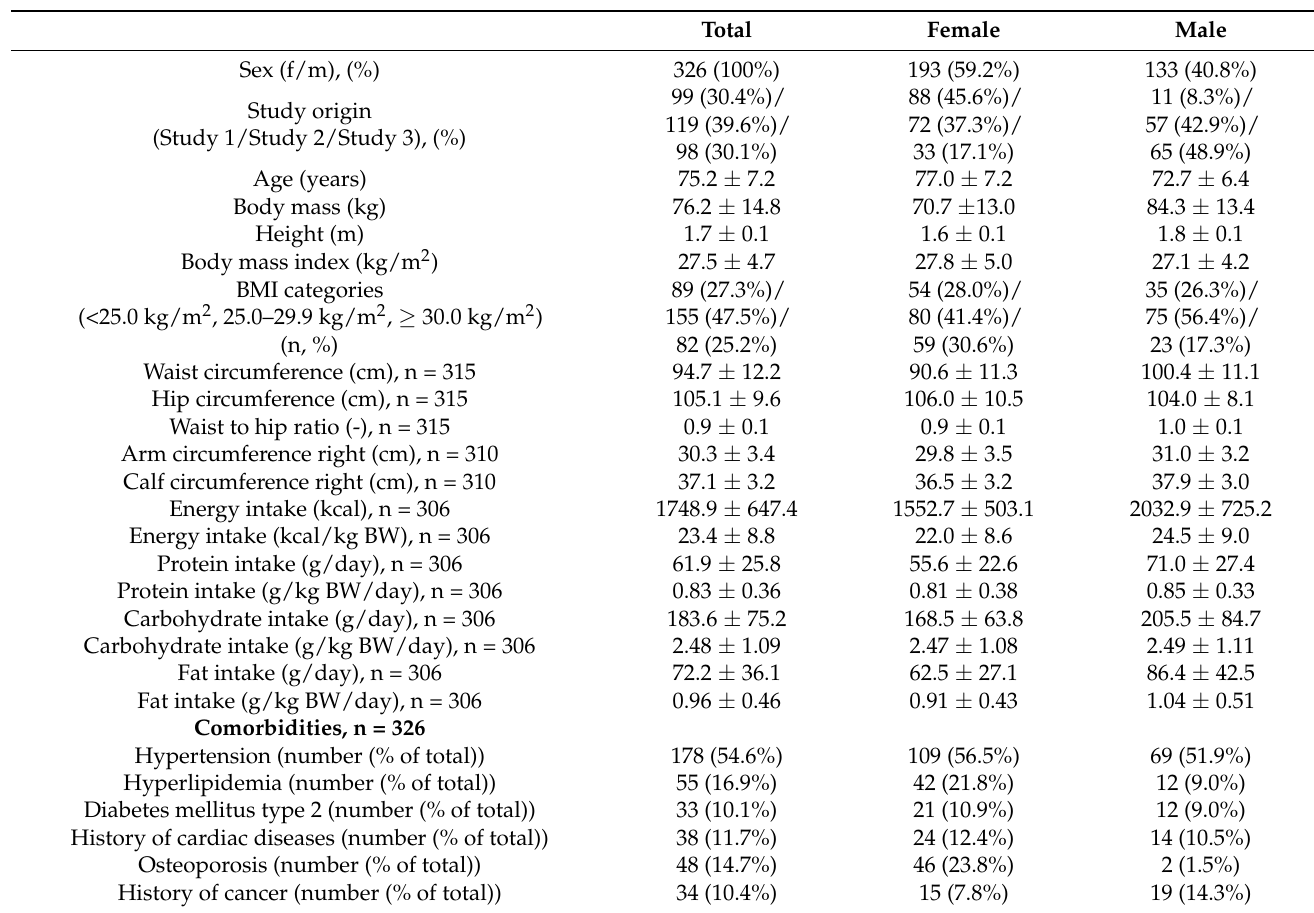
Table 1. Anthropometric, macronutrient intake and comorbidity characteristics of the participants. Total Female